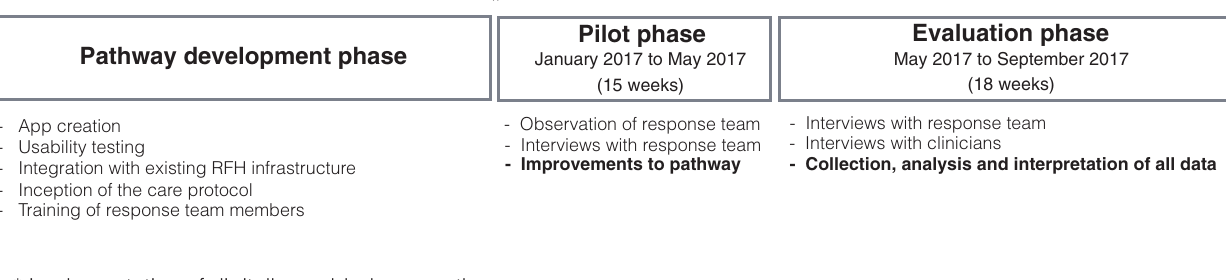
Figure 1. Evaluation phases. Phases of the evaluation are listed in order. A summary of the main aims of each phase is also listed. The digitally-enabled care pathway was implemented in January